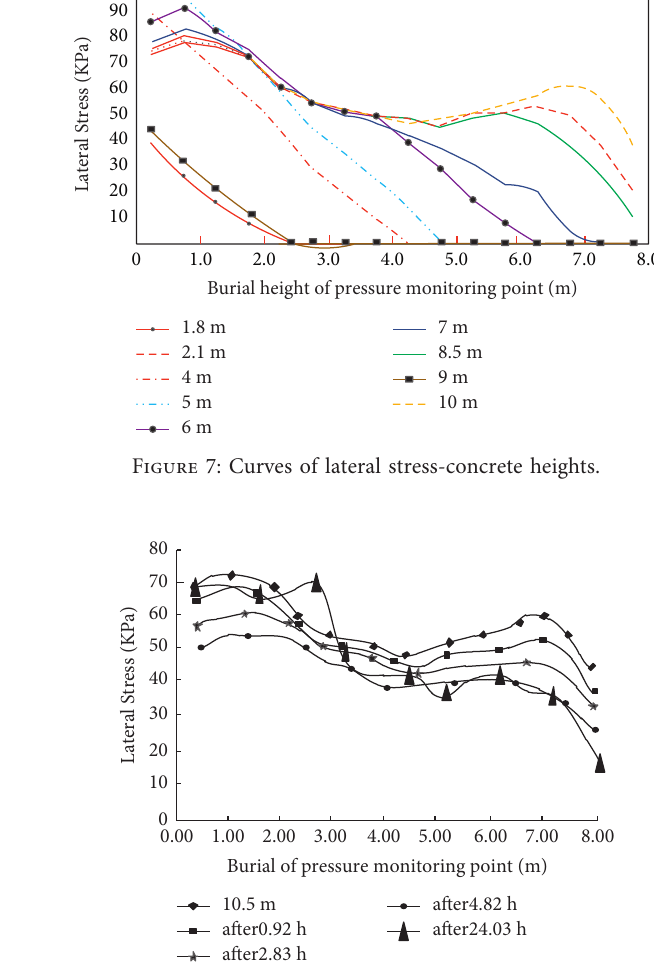
Figure 8: Distribution of lateral stress along with the height at different times.